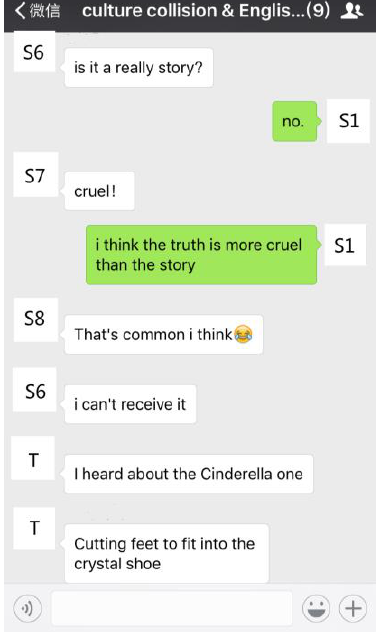
Figure 2-A. Discussion about fairy